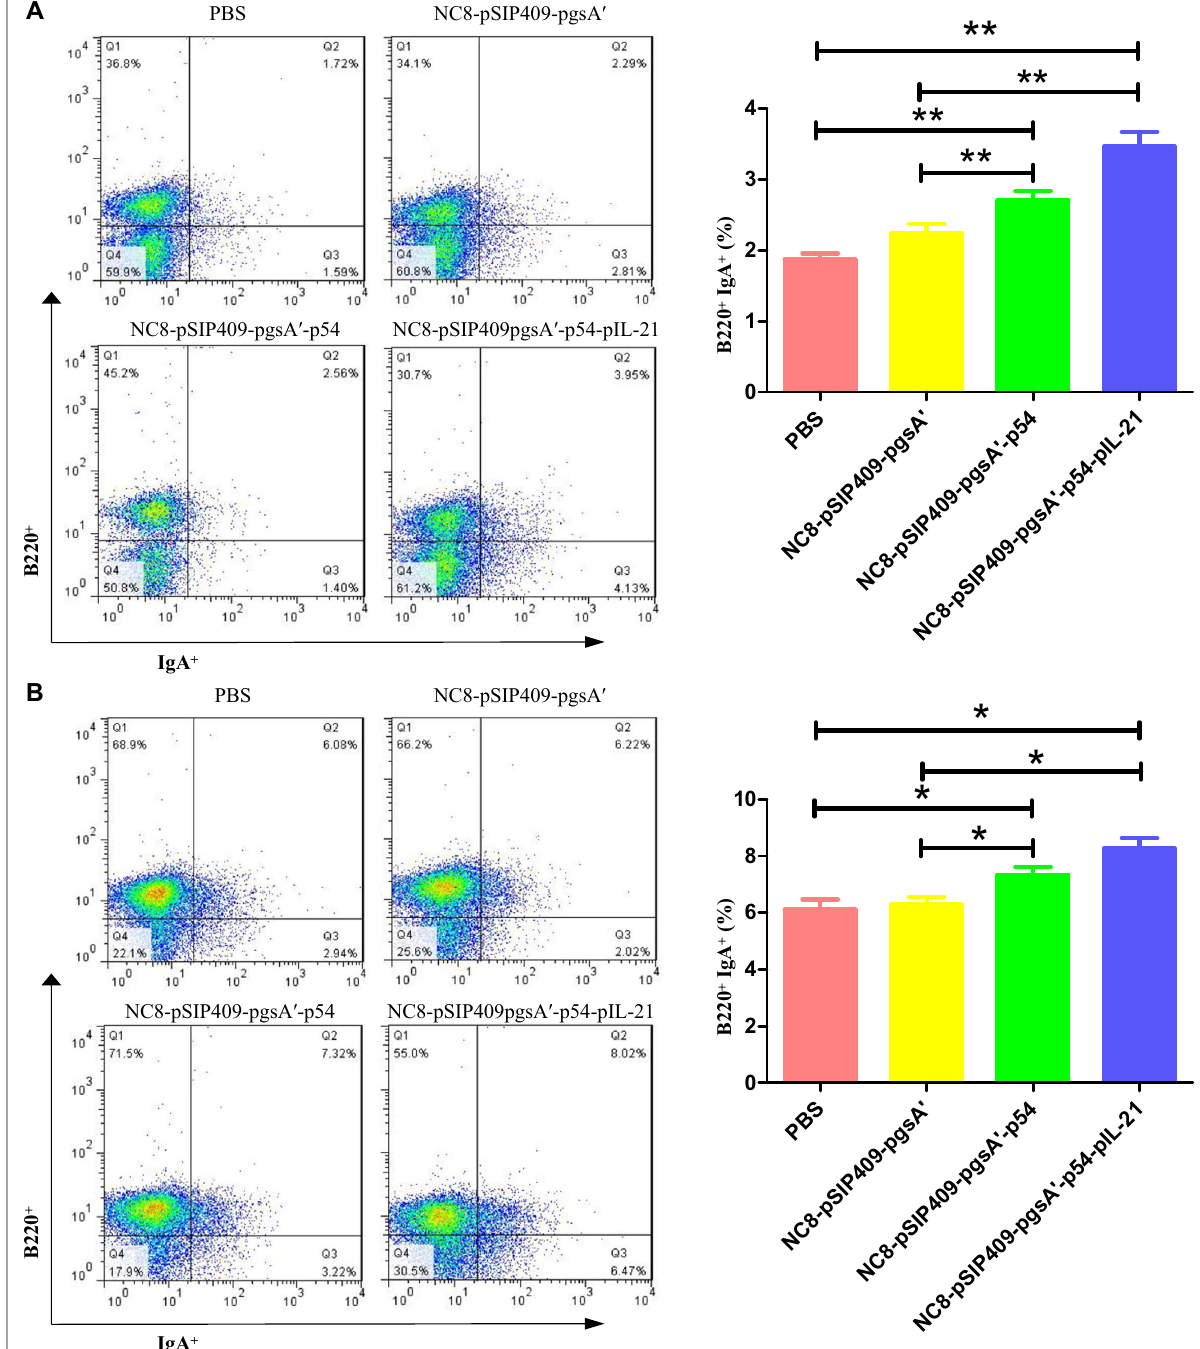
Fig. 2 A Statistical analysis of lymphocyte expression of B220 and IgA in mouse PPs; B statistical analysis of lymphocyte expression of B220 and IgA in mouse